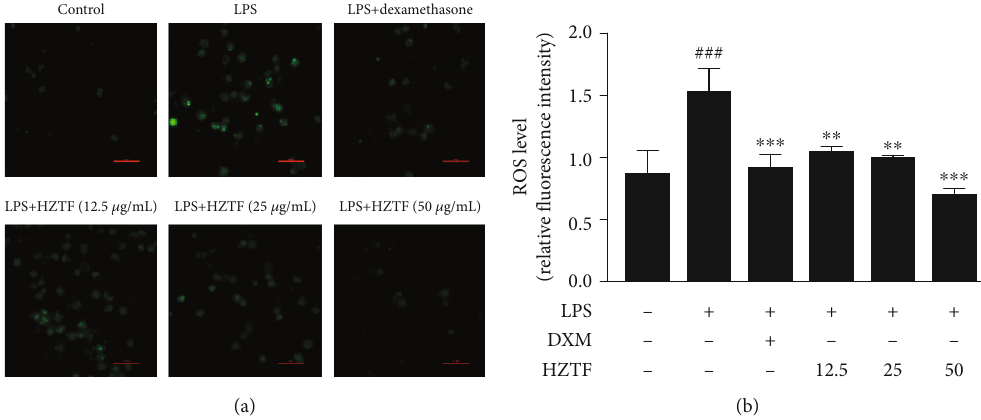
Figure 5: E ff ects of HZTF on LPS-induced ROS accumulation in RAW264.7 cells. After pretreatment with HZTF (12.5, 25, and 50 μ g/mL) or positive drug (dexamethasone at 10 μ g/mL) treatment for 2h then treatment with LPS (100ng/mL) for 24h, cells were incubated with 10 μ M DCFH-DA for 30min. (a) The fl uorescent microscopy showing production of intracellular ROS (scale bar: 50 μ m). (b) The relative fl uorescence intensity was analyzed by the Image J software (version 1.51). Data were presented as the mean ± SD ( n = 3 ). ### P < 0 : 001 , compared with the control group; ∗∗ P < 0 : 01 , ∗∗∗ P < 0 : 001 , compared with the LPS